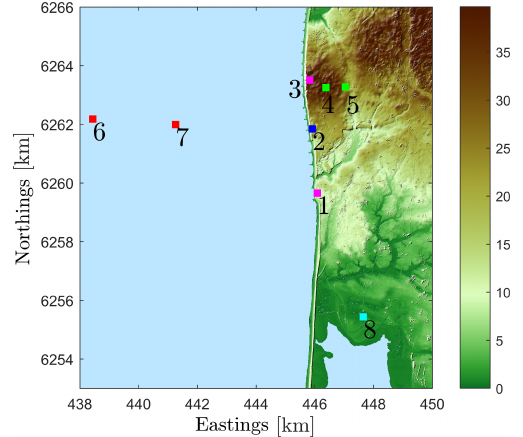
Figure 1. Map of the area of the RUNE campaign indicating the po- sitions of the dual-set-up lidars (1 and 3), the PPI lidar (2), the profil- ing lidars (2, 4, 5, 6 (7)), the met mast (8) and the wave buoy (9) lo- cated 150m away from position 6. The colour bar shows the height above mean sea level in